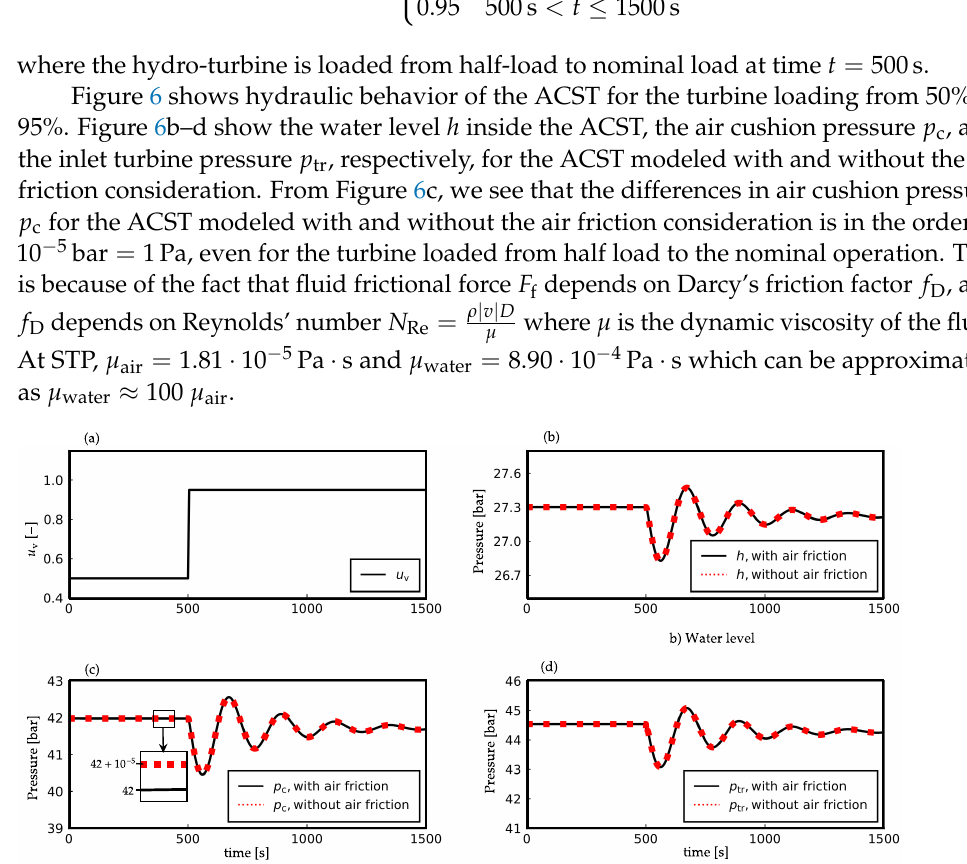
Figure 6. ACST model with and without frictional force due to the air inside ACST for Torpa HPP, ( a ) turbine valve signal u v , ( b ) water level h inside ACST, ( c ) air cushion pressure p c , and ( d ) turbine inlet pressure p tr